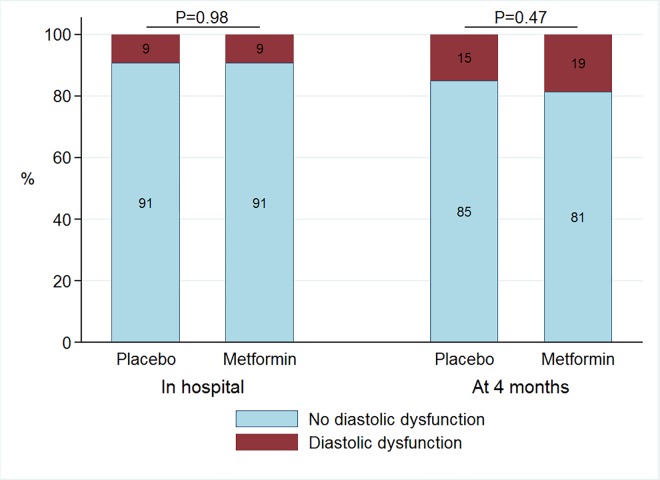
Barchart of classification of diastolic function during hospitalization and at 4 months according to randomization.